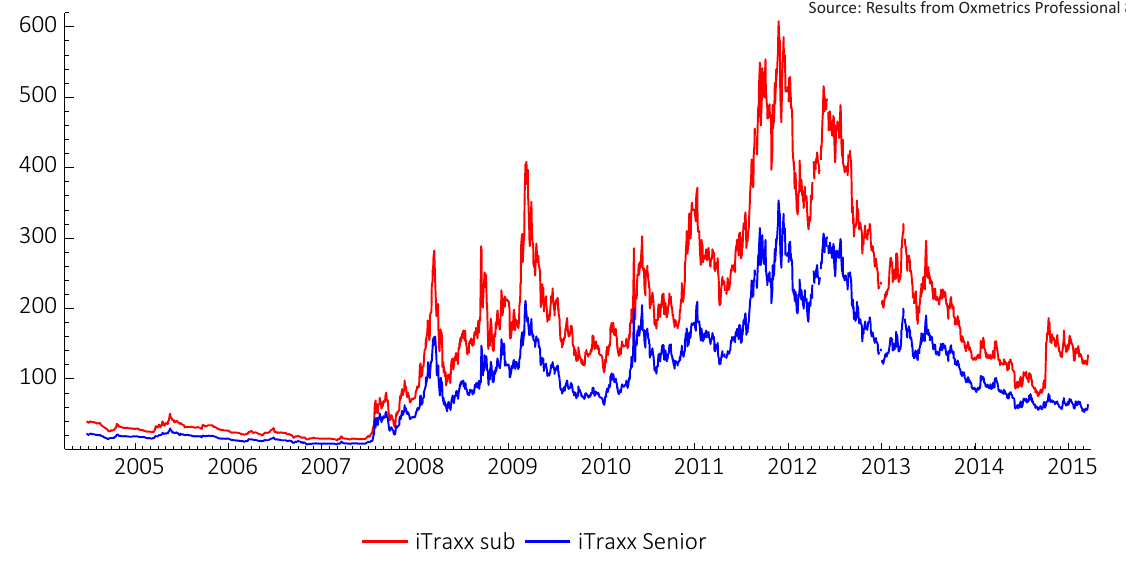
iTraxx sub iTraxx Figure 2. iTraxx Financials Europe spreads for subordinated and senior debt